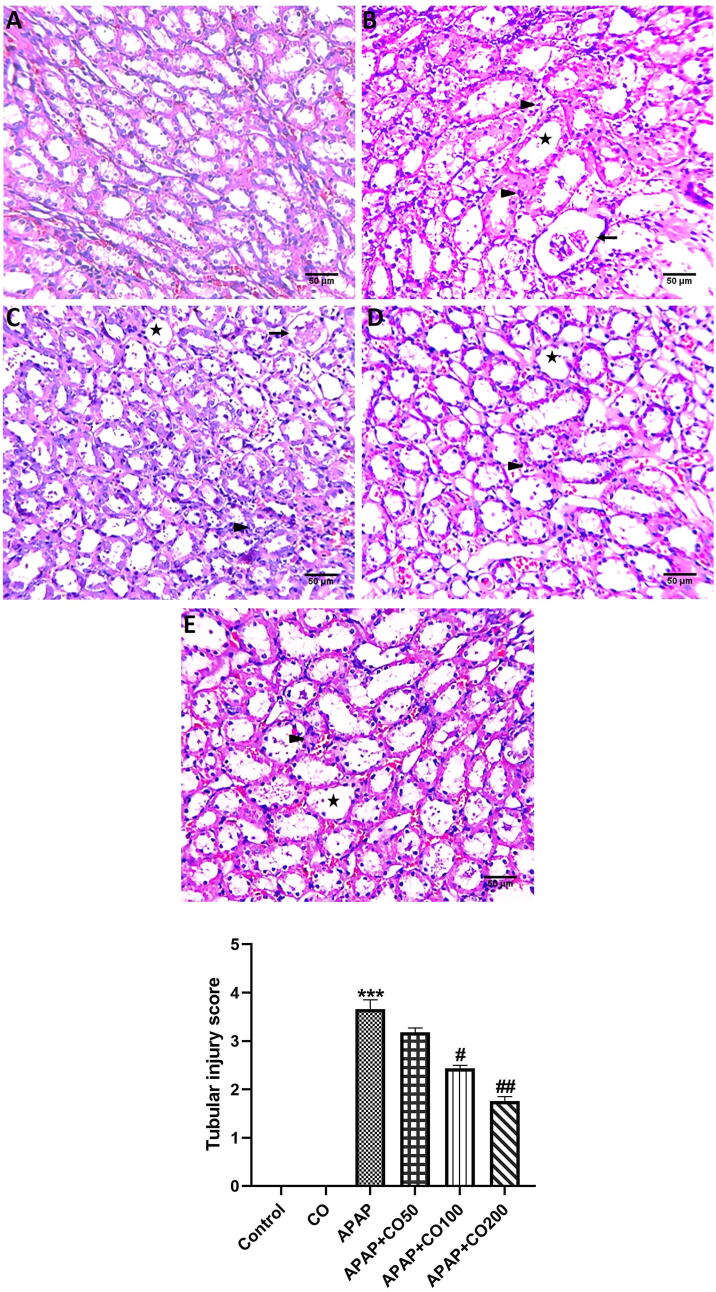
Effect of CO on morphological changes in APAP treatment rat using H&E staining in the kidney of control, APAP and different doses of APAP + CO groups. Kidneys from the control group (A) showed no histological changes. Pathological alteration included infiltrating cells and tubular necrosis (arrowhead), epithelial degeneration (arrow), tubular dilatation (star), and swelling in APAP treated rats (B). Histological damages were ameliorated in kidneys from rats treated with CO in APAP + CO (C, D and E) when compared with kidneys in rats treated with APAP alone. Values are expressed in means ± S.E.M. (n = 6). ***P < 0.001 APAP vs. control group; #P < 0.05, ##P < 0.01 APAP + CO vs. APAP alone-treated group.